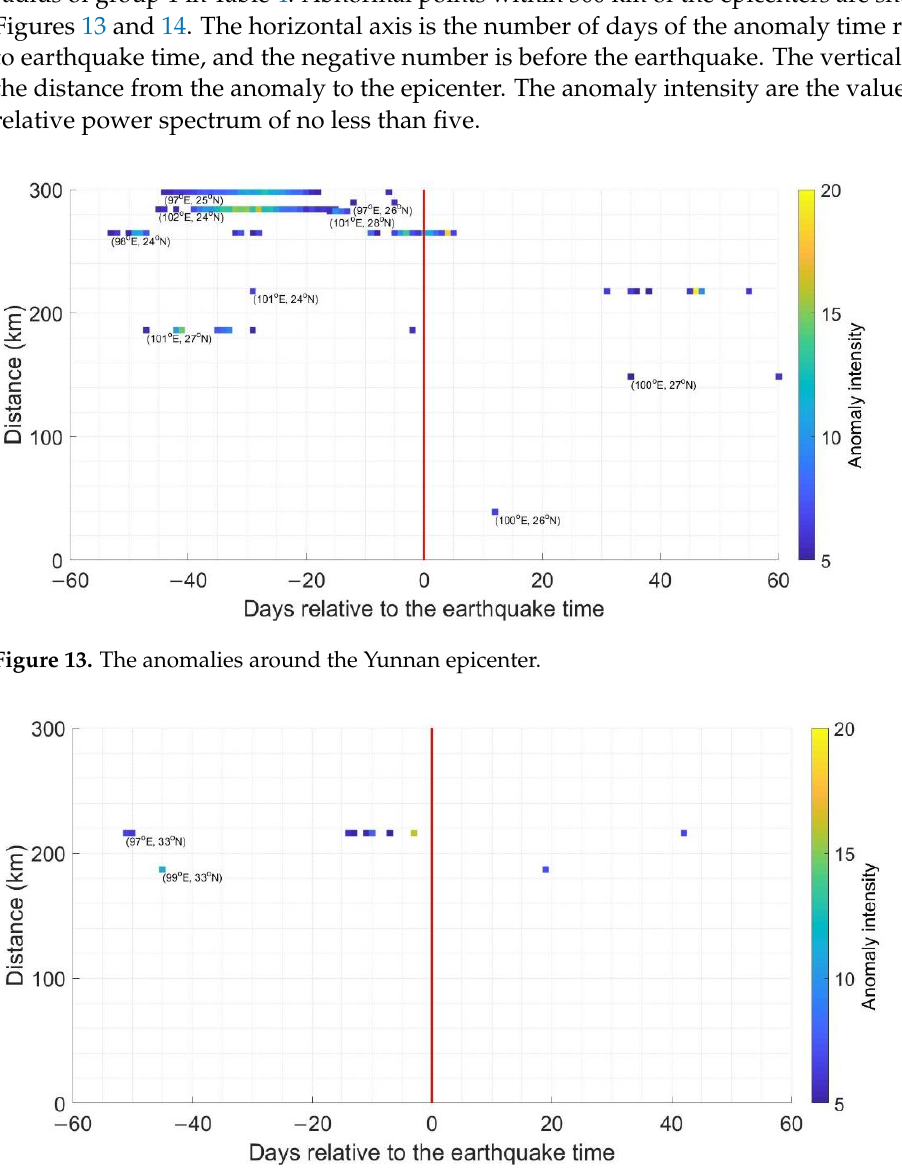
Figure 14. The anomalies around the Qinghai epicenter.